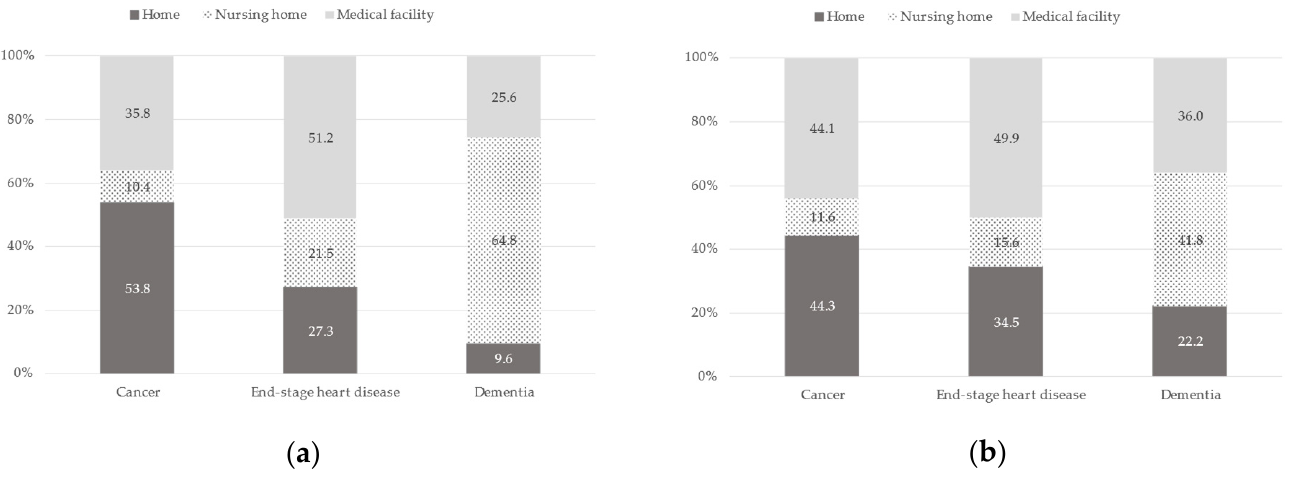
Figure 2. Proportion of preferred place of care by assumed clinical scenario, N = 889.